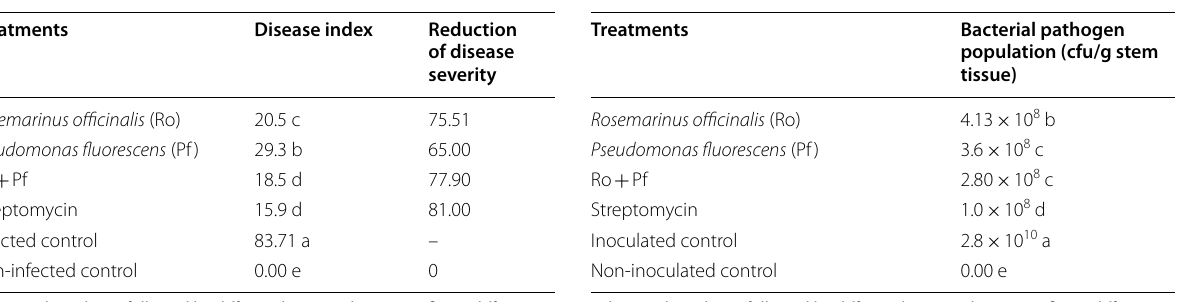
Values in the column followed by different letters indicate significant differences 0.05) among treatments according to a least significant differences test ( P =